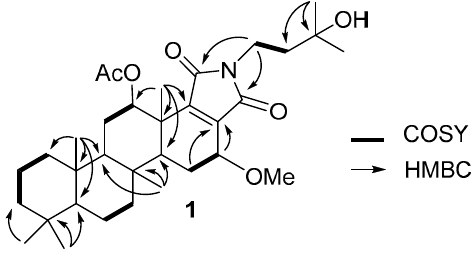
Figure 2. Key 1 H- 1 H COSY and HMBC correlations of 1 .